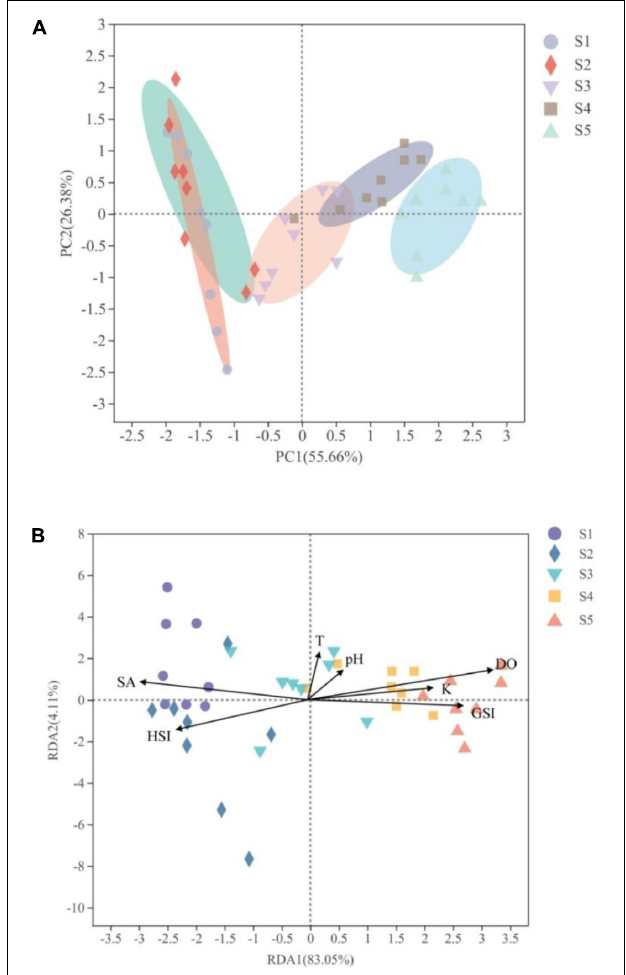
FIGURE 2 | Comparison of the main biochemical compositions in the different groups studied of Megalobrama terminalis . (A) Principal coordinate analysis (PCA) of main biochemical compositions in M. terminalis ovary from different groups. The individual samples are color-coordinated according to the different locations. (B) Redundancy analysis (RDA) showed the correlation between the biochemical compositions of the different groups studied of M. terminalis and their biological indices and habitat environment